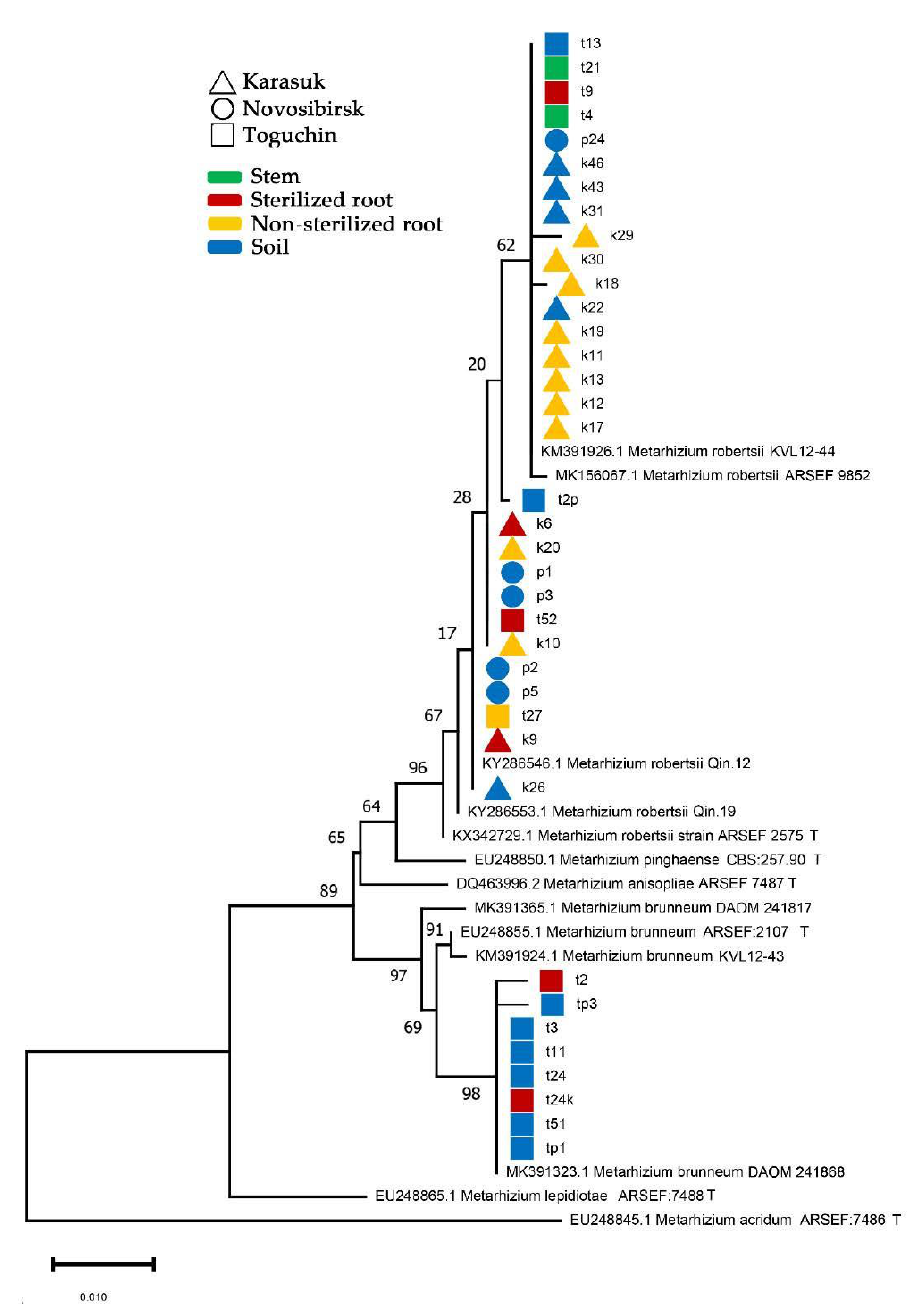
Figure 4. Phylogenetic reconstruction showing the position of Metarhizium isolates based on the 5′EF-1α region sequence obtained using maximum likelihood based on the Tamura–Nei model with 1000 replicates; bootstrap support is indicated on the branches.